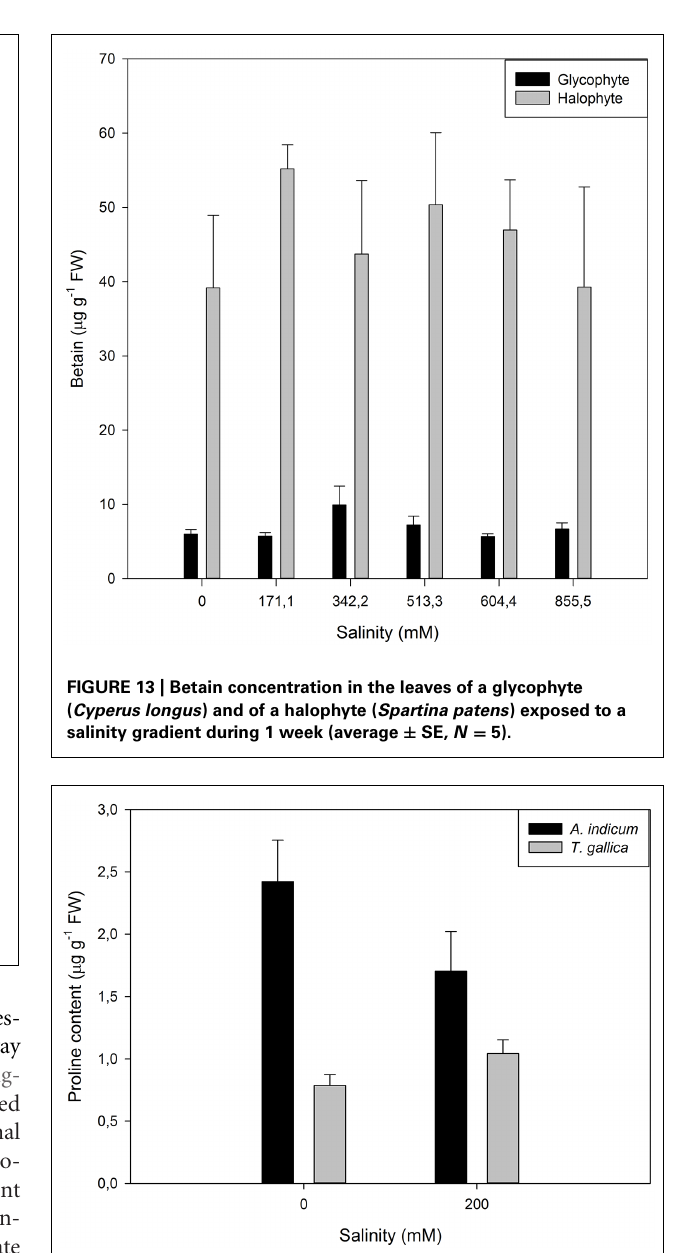
FIGURE 14 | Proline content in aboveground organs of Arthrocnemum indicum and T. gallica exposed to a salinity gradient during 20 days (average ± SE, N =